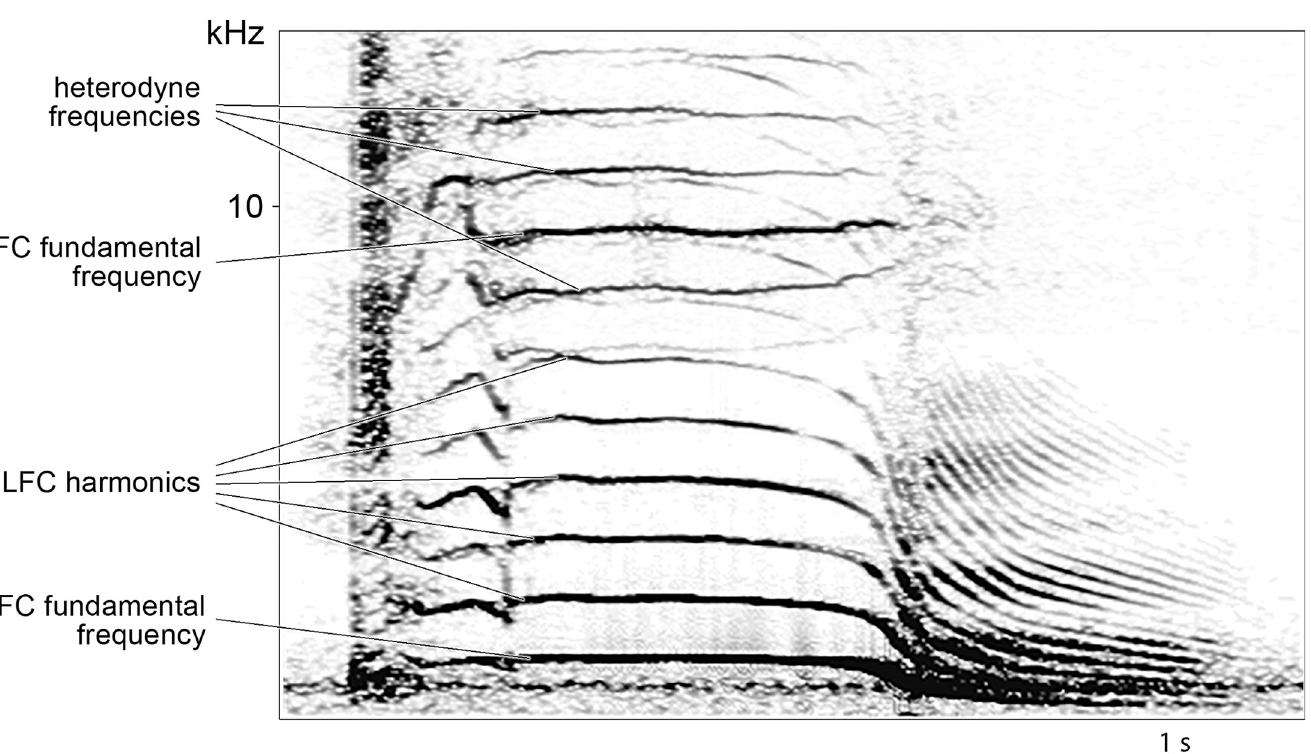
Fig 4. Biphonic K5 call type showing heterodyne frequencies above and below the higher-frequency component. Heterodyne frequencies arise from the interaction between the lower- and higher-frequency components; the frequency of the first heterodyne above the higher-frequency component is equal to the frequency of the higher-frequency component plus the frequency of the lower-frequency component, the frequency of the second heterodyne above the higher-frequency component is equal to the frequency of the higher-frequency component plus the frequency of the first harmonic of the lower-frequency component, and so on; the same principle applies to the heterodynes below the higher-frequency component, but with minus instead of